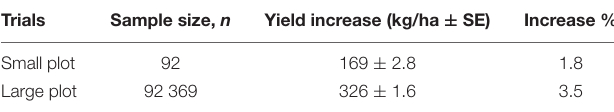
TABLE 1 | Summary of small and large plot field trials to measure maize yield response to inoculation with the phosphorus-solubilizing fungus Penicillium bilaiae (adapted from Leggett et al.,